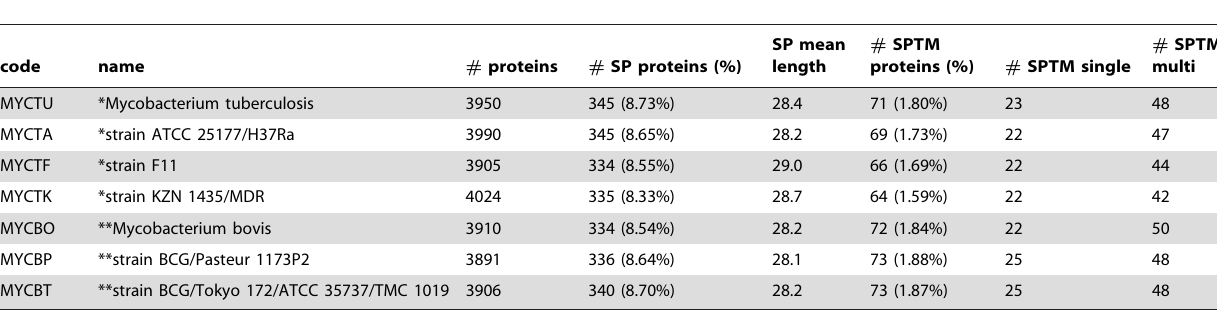
Table 5. Basic statistics in the selected seven proteomes of Mycobacterium tuberculosis (*) and Mycobacterium bovis (**).